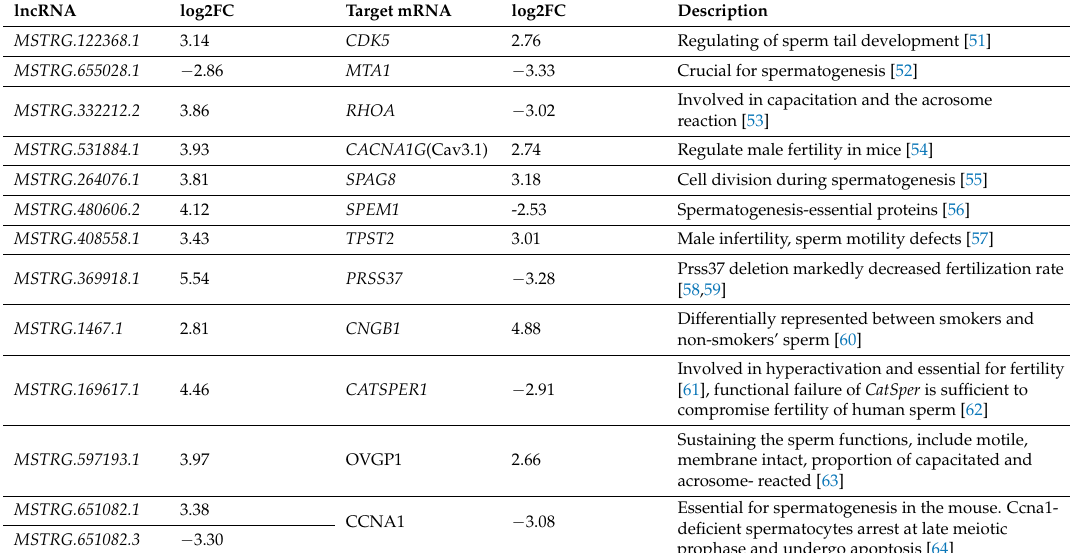
Table 1. Function of lncRNAs and target mRNAs that were significantly differentially expressed between fresh and frozen-thawed giant panda sperm. Log2FC, log2 fold-change.